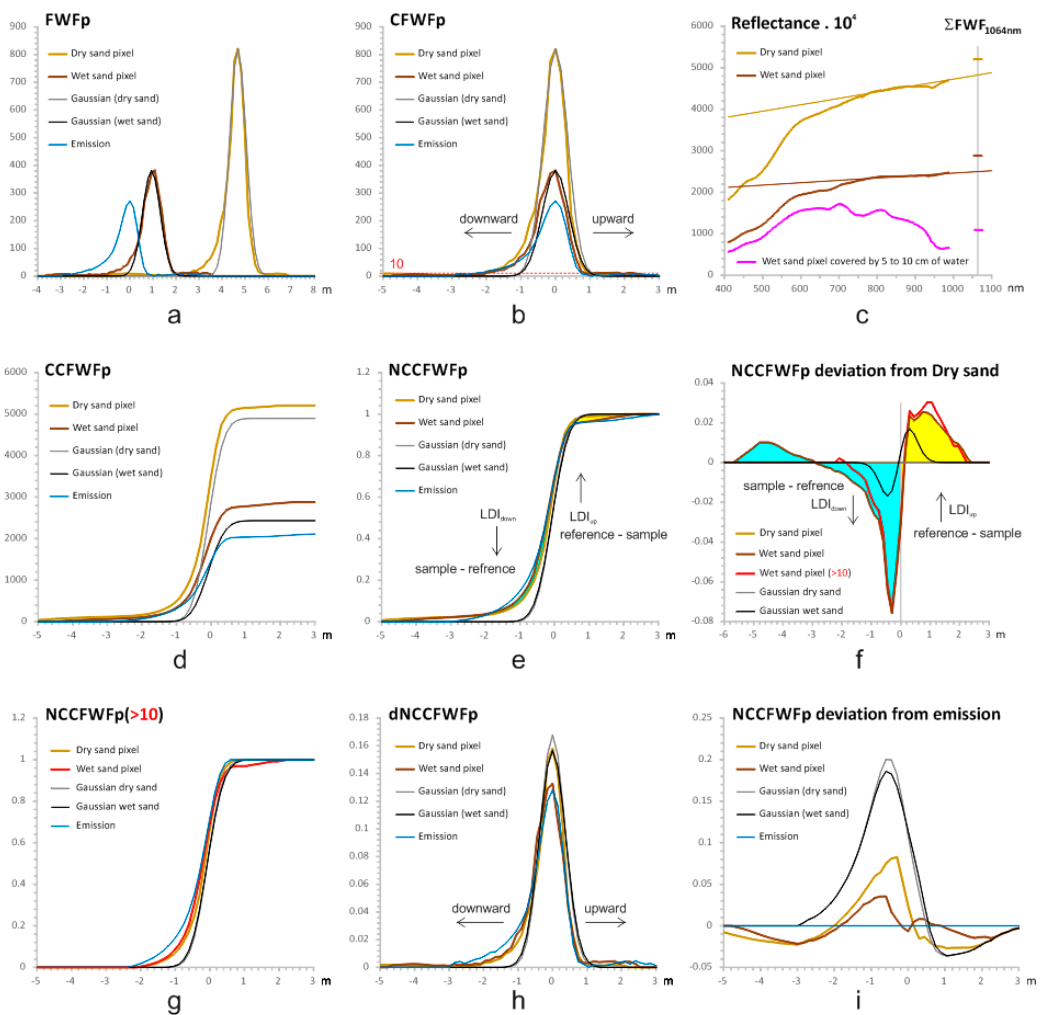
Figure 3. FWF analysis: ( a ) FWF ray tracing pixels (FWFp, DN) of dry and wet sand, their respective Gaussian fits, and shape (without a scale factor) of the emitted pulse; ( b ) centered FWFp (CFWFp); ( c ) corresponding reflectance in nanometers as stored in image files in integer times 10 4 with a plot of FWFp sum at 1064 nm, the magenta spectra and corresponding FWFp represent a pixel of wet sand covered by water chosen out of areas of sun glint; ( d ) cumulative centered FWFp (CCFWFp); ( e ) normalized cumulative centered FWFp (NCCFWFp); ( f ) NCCFWFp deviation from dry sand for ( e , g ); ( g ) normalized cumulative centered FWF greater than 10 (NCCFWFp > 10); ( h ) derivative of NCCFWFp of ( e ) (dNCCFWFp); and ( i ) NCCFWFp deviation from the emitted pulse for ( e ). FWF are given in relative units versus m with 0.149 m per channel. Reflectance samples are in reflectance times 10 4 as stored in images. Upward and downward LiDAR diffusion indices (LDI) are discussed in the text.